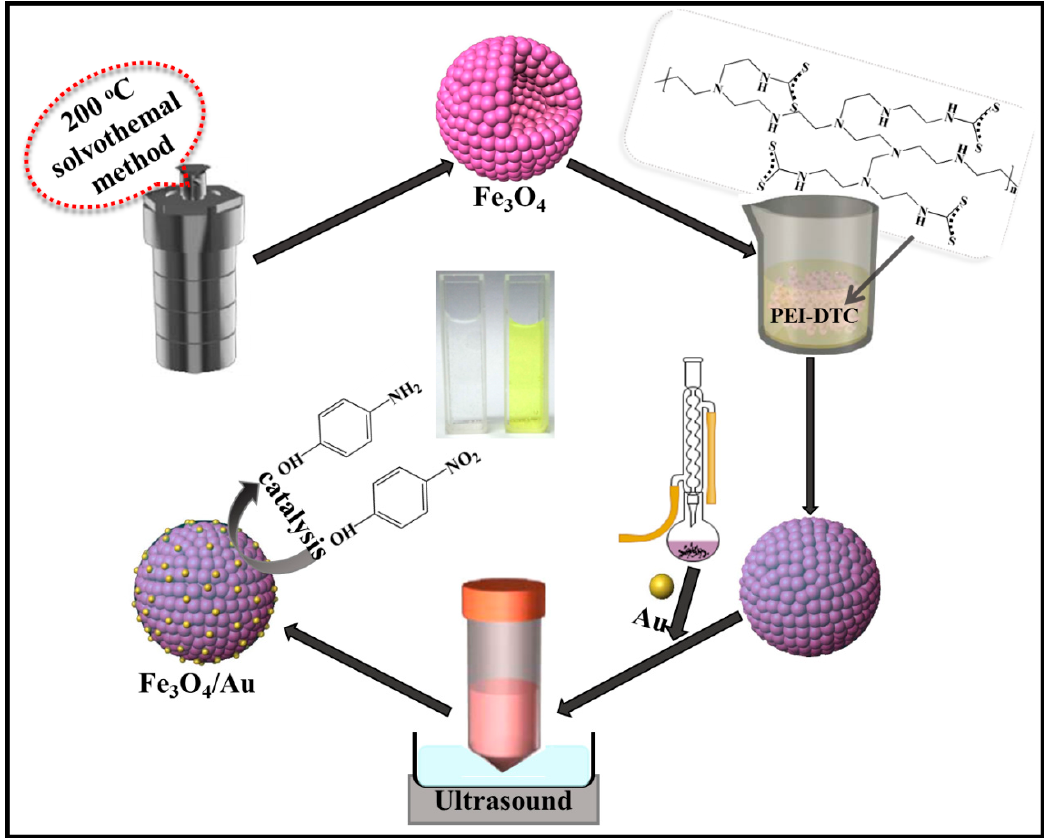
Figure 1. Schematic illustration of the fabrication process and catalytic application to 4-nitrophenol (4-NP) of Fe 3 O 4 -Au magnetic nanocomposites. PEI-DTC, polyethyleneimine-dithiocarbamate.